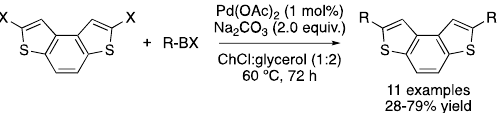
Figure 22. Application of Suzuki coupling to benzodithiophene derivatives.